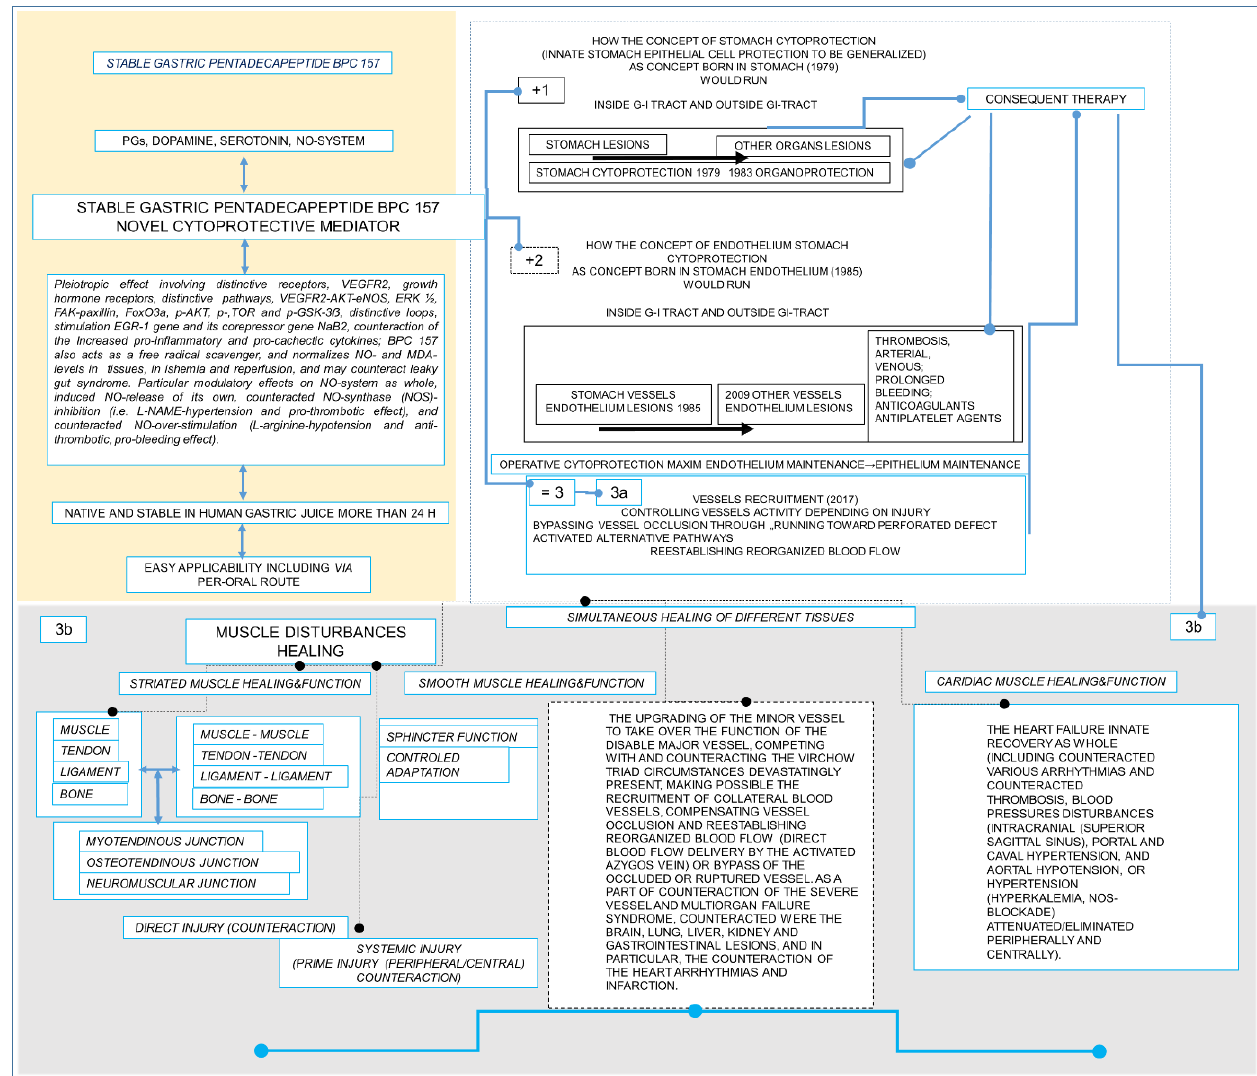
Figure 11. Summarization of particular way in which the stable gastric pentadecapeptide BPC 157 might beneficially act on striated, smooth, and heart muscle. BPC 157 (yellow box). Stable gastric pentadecapeptide BPC 157, a peptide that is native to and stable within human gastric juice for periods of time longer than 24 h, has demonstrated extremely positive healing effects for various injury types in numerous organ systems, and muscle systems in particular. Providing specific effects in conditions of sickness [58,96], and also at the molecular level, BPC 157 accelerated the ex occurred as one of the most abundantly up-regulated genes in tendon fibroblasts by BPC 157 through Janus kinase 2, the downstream signal pathway of growth hormone receptor [59]. BPC 157